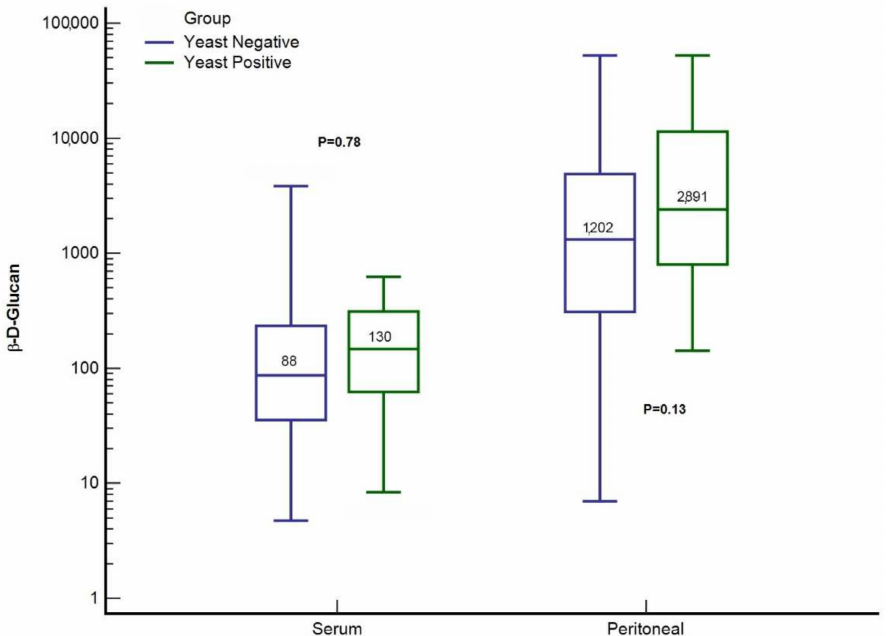
Figure 2. Initial serum and peritoneal (1,3)-ß- D -glucan concentrations in patients with complicated intra-abdominal infections. Values are in pg.mL − 1 .